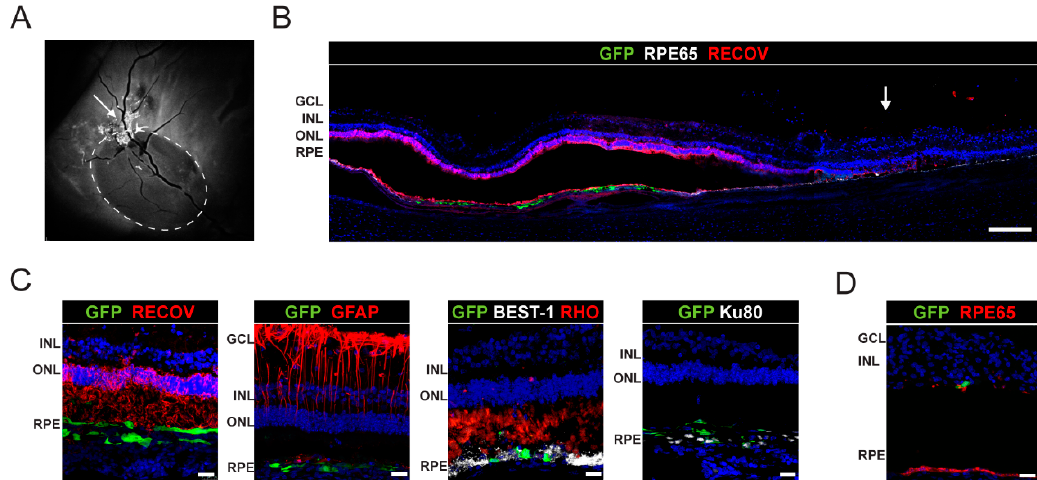
Figure 5. Analysis of engrafted hiPSC-RPE cells in the host porcine retinas at two weeks post-transplantation in pig 4. ( A ) FAF shows hyper-fluorescence corresponding to hiPSC-RPE cells located in an area covering the healthy retina, the limiting margin, and a small part of the atrophy (circle denotes the atrophic zone). ( B ) Immunohistochemical analysis shows hiPSC-RPE cell integration in healthy retinas close to the margin of the atrophy stained with RPE65 and recoverin (RECOV) (white arrow indicates the atrophy border). Scale bar: 250 μ m. ( C ) Confocal images show engrafted hiPSC-RPE cells (GFP in green) in healthy retina, stained with recoverin and rhodopsin (RECOV and RHO), expressing bestrophin-1 (BEST-1) and Ku80 (human nuclear marker). Astrocytes show normal morphology (GFAP). Scale bars: 25 μ m. ( D ) Immunofluorescence images of hiPSC-RPE integration in atrophic areas stained with RPE65. Scale bars: 25 μ m. Cell nuclei were stained with DAPI (blue). FAF, fundus autofluorescence; RPE, retinal pigment epithelium; OS, outer segments; ONL, outer nuclear layer; INL, inner nuclear layer; GCL, ganglion cell layer; Chor, choroid; GFP, green fluorescent protein.